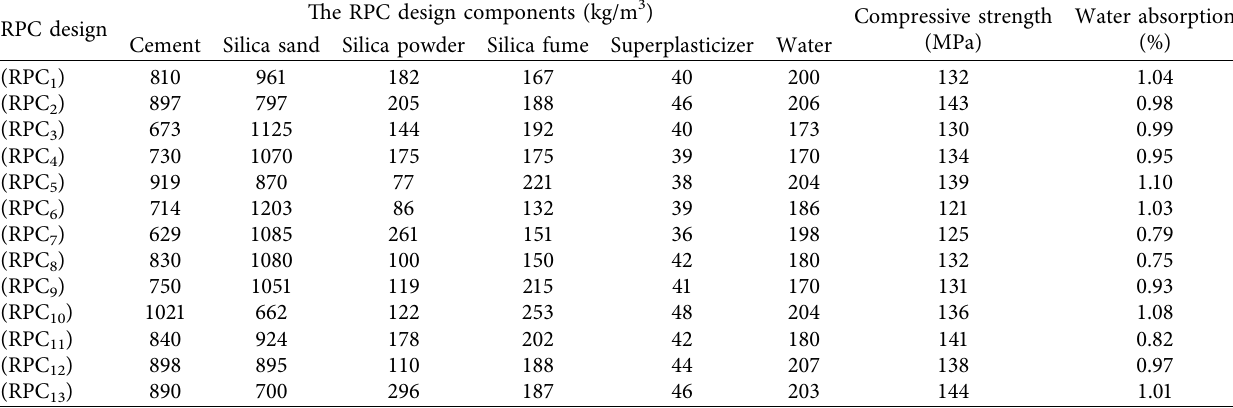
Table 6: Components of selected RPC designs [55].